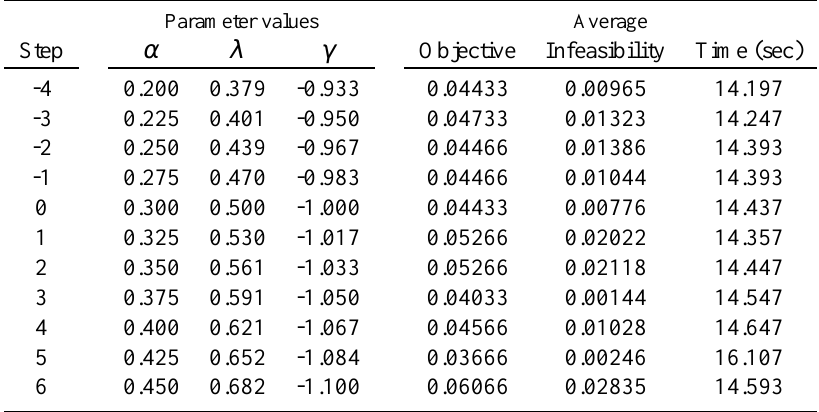
Table 5. Average results for 3 instances with n =1000 and p